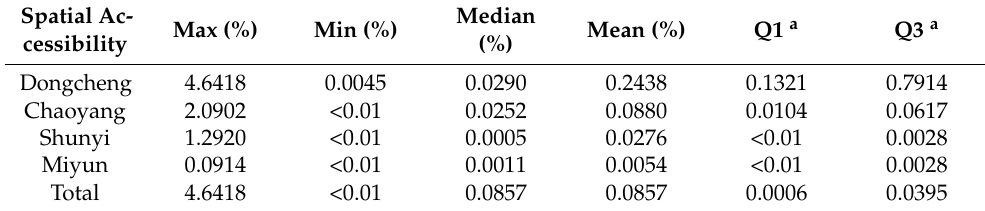
Figure 5. Accessibility index of community hospitals within walking distance of four districts. Table 3. Spatial accessibility index of four